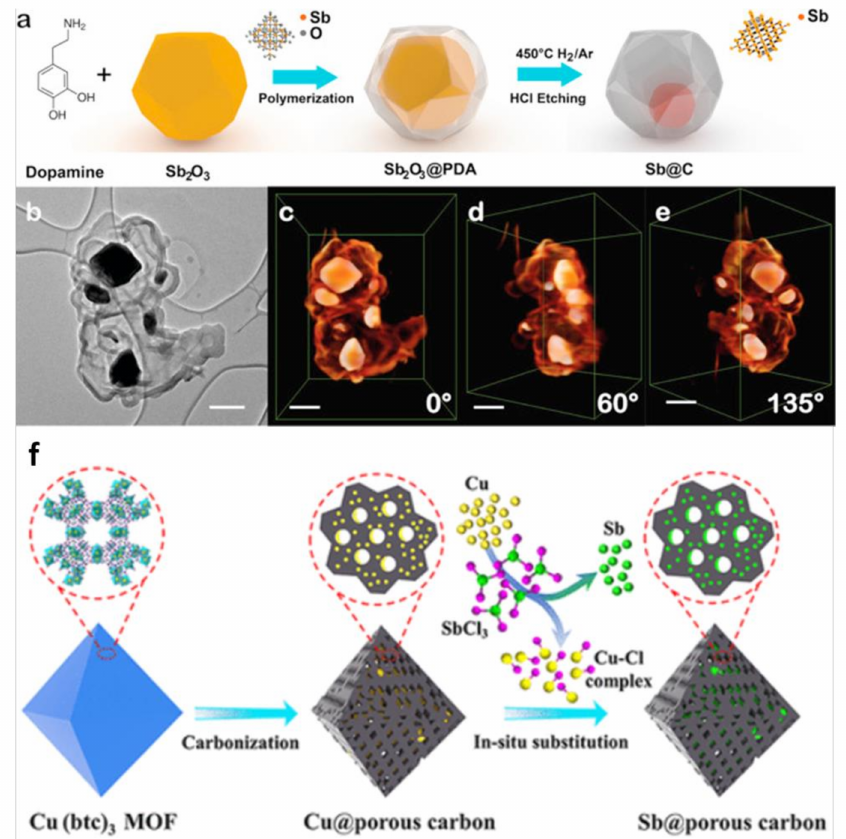
Figure 3. ( a ) Schematic figure of the synthesis process; ( b ) TEM image of a typical Sb@C yolk-shell structure; ( c – e ) Screen shots of the 3D reconstruction of the Sb@C structure (scale bar: 200 nm); ( f ) MOF-derived octahedron carbon